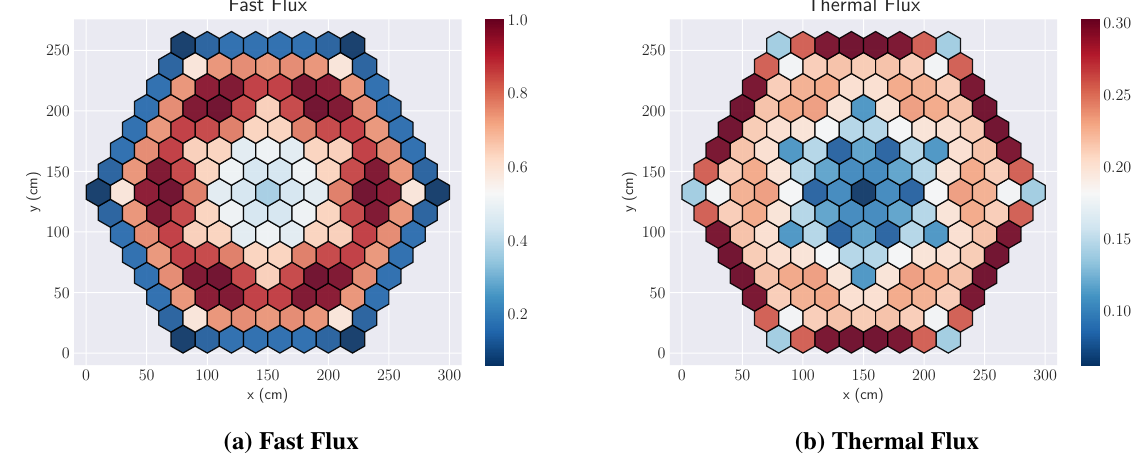
Figure 2: Static neutron fluxes in the IAEA